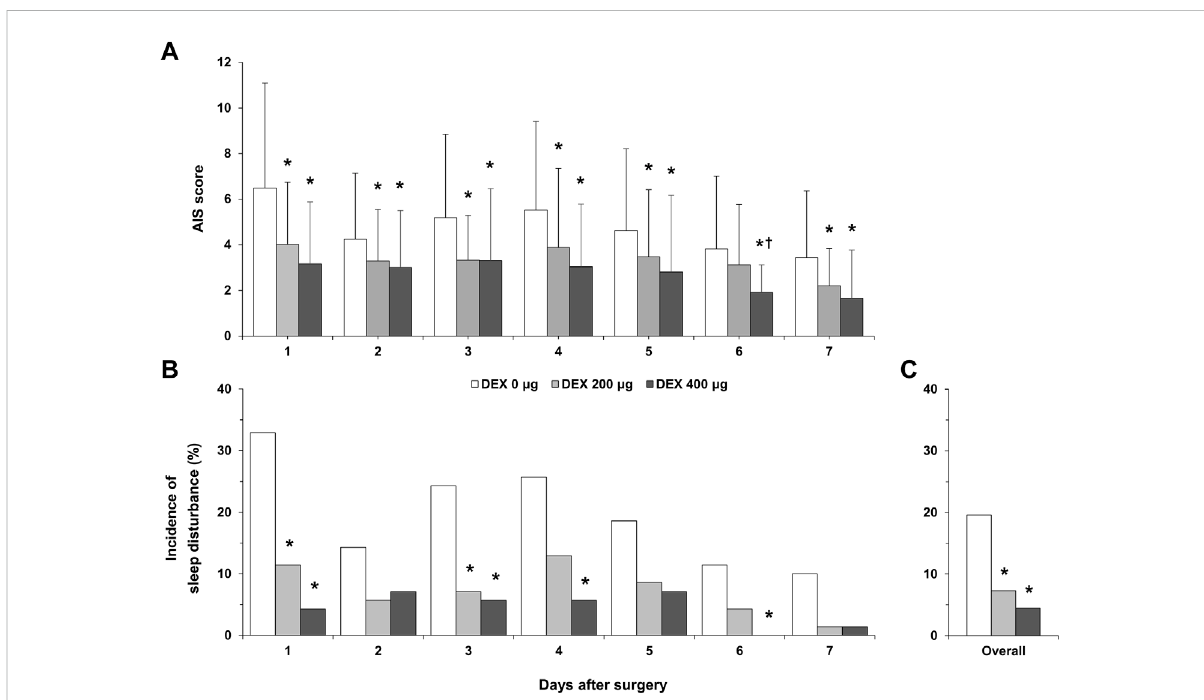
FIGURE 2 Postoperativesleepquality. (A) ,AISscoreover7postoperativedays; (B) ,incidenceofpostoperativesleepdisturbanceover7postoperativedays; (C) , overall incidence of postoperative sleep disturbance during the fi rst 7 days after surgery. DEX, dexmedetomidine; AIS, Athens Insomnia Scale; * p < 0.05, vs. DEX 0 μ g; † p < 0.05, vs. DEX 200 μ g.